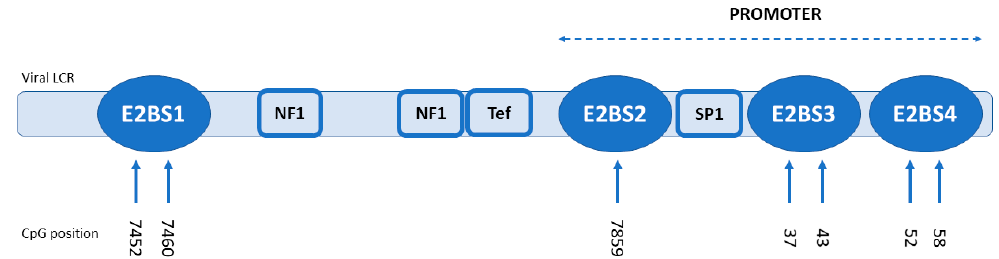
Figure 1. CpG nucleotide positions in the HPV16 long control region (LCR), as compared with the HPV16 reference sequence (GenBank: K02718.1).